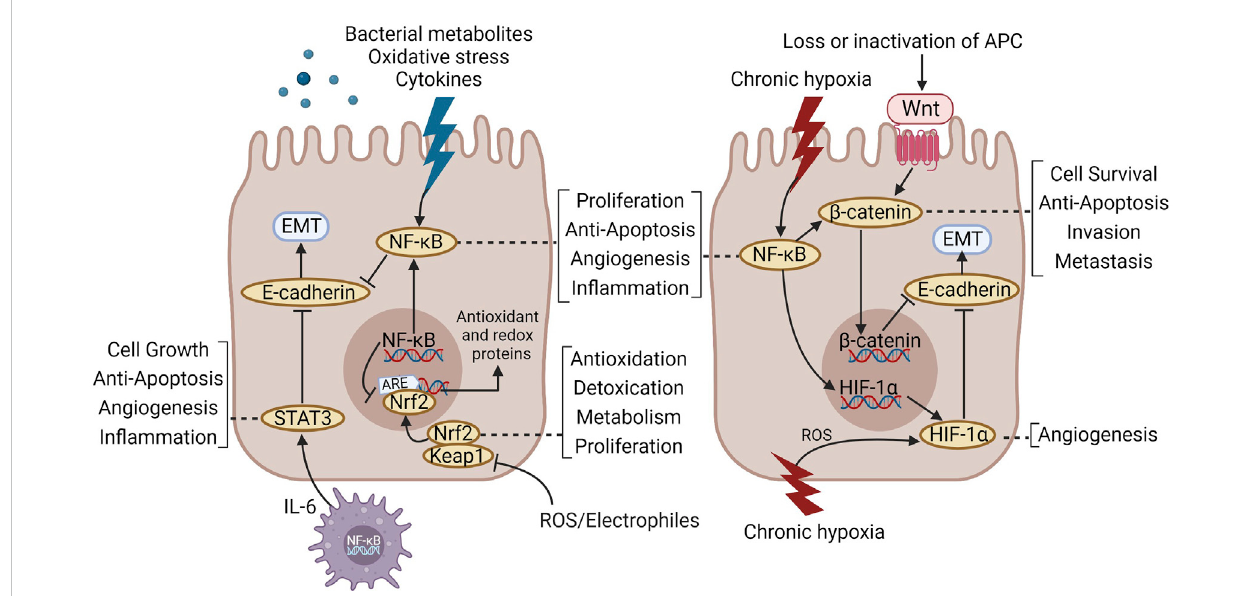
The main signal pathways involved in the treatment of CAC with TCM